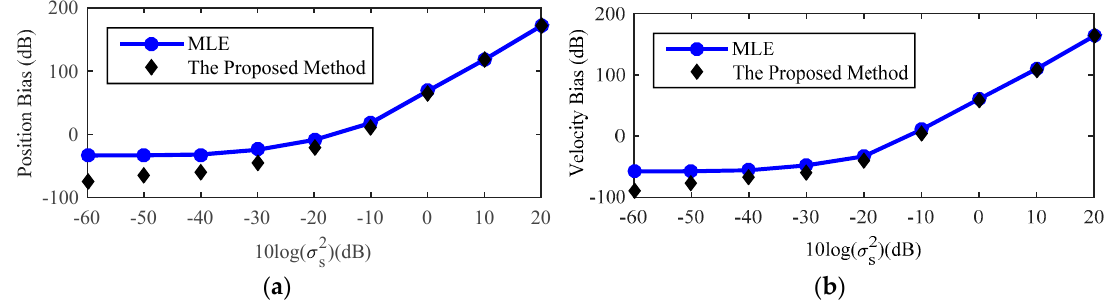
Figure 12. Bias comparison of the proposed method with the original MLE for far-field source. ( a )